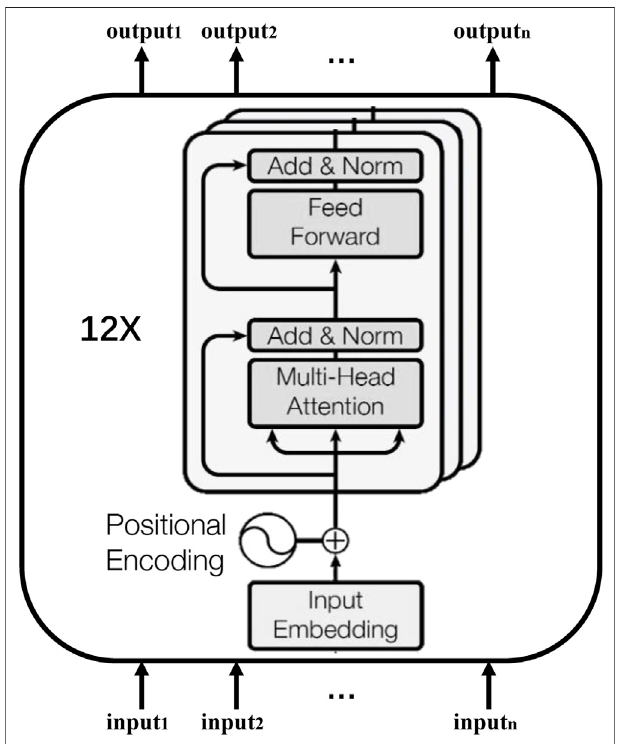
FIGURE 1 | The BERT